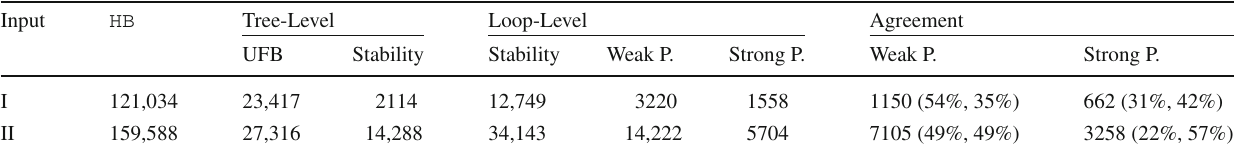
generalised unitarity constraints with renormalised couplings. Under Table 1 Summary of the results of a random scan using Input I and ‘Agreement’, we list the number of points which pass both the tree- II. A sample with 250,000 points each has been generated which pass and loop-level constraints. We show in brackets how many of the points the tree-level unitarity constraints. The numbers give the points surviv- passing the tree-level constraints also pass the loop constraints and vice ing the different cuts. As weak perturbativity cut we applied the MS versa condition based on the hierarchy of the one- and two-loop corrections to the masses of the CP-even neutral scalars. The strong cut uses the Agreement Stability Stability Weak P. Strong P. Weak P. Strong